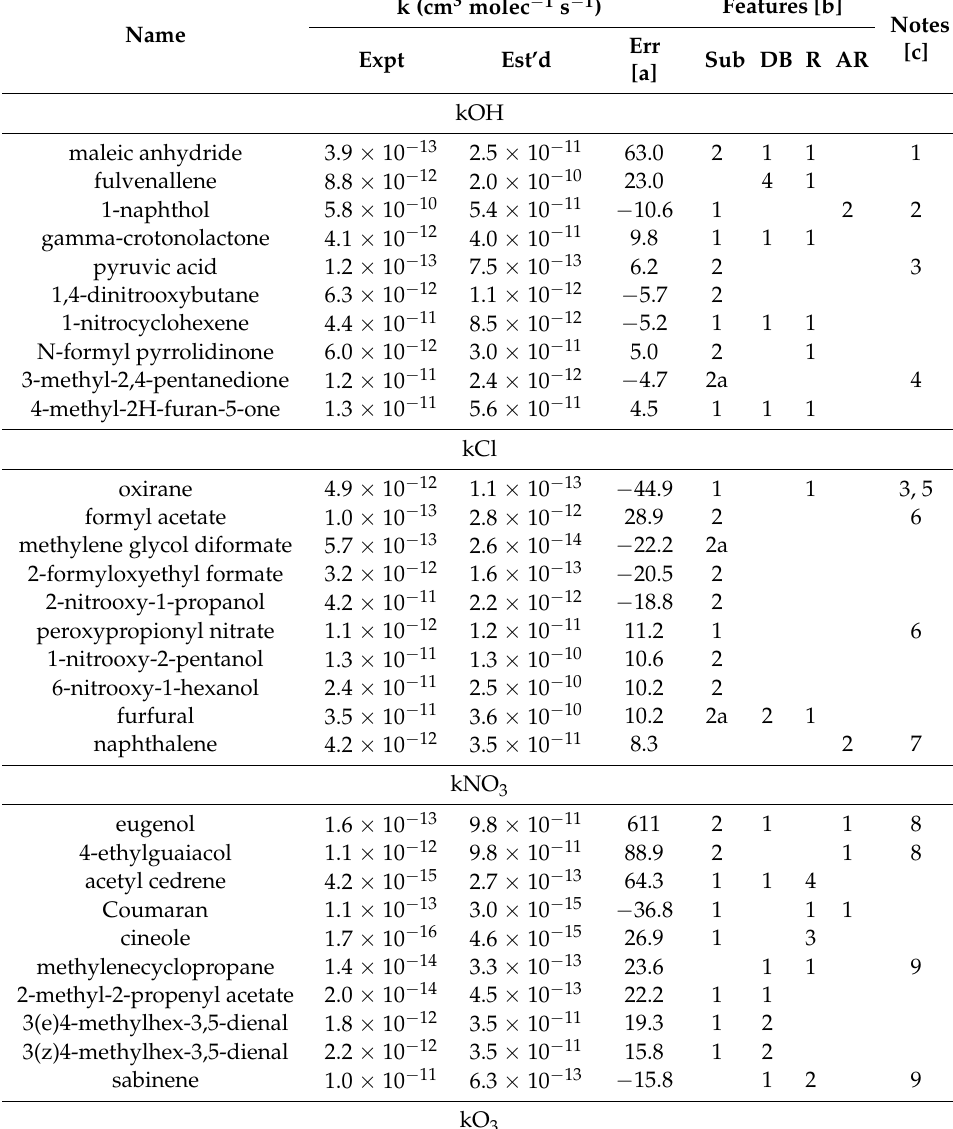
Figure 3. Fractions of compounds with errors greater than 30% or a factor of 2 for estimations of rate constants for reactions with OH, Cl, NO 3 , and O 3 . Table 4. Compounds where estimates of the rate constants failed by the largest factors.